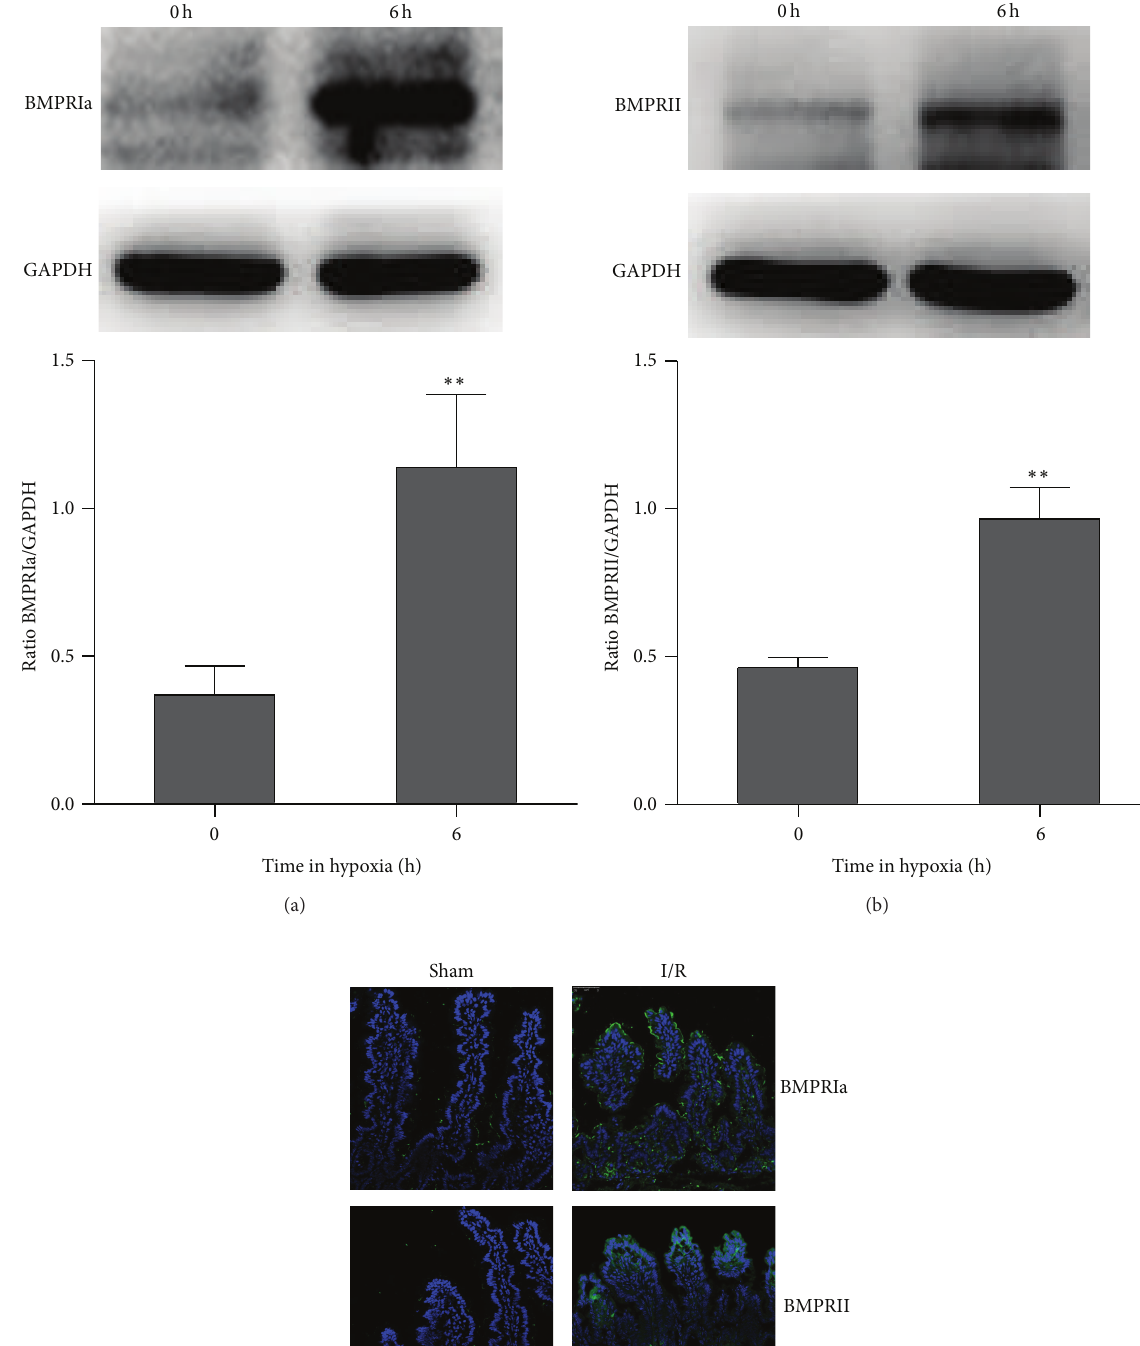
Figure 2: (a) and (b), (c) BMPRIa and BMPRII expression was detected by Western blotting and immunofluorescence staining. BMPRIa and BMPRII expression levels were both significantly increased after 6 h of hypoxia in IEC-6 cells. ∗∗ 𝑃 < 0.01 versus control. BMPRIa and BMPRII expression in the intestinal mucosa also increased after I/R for 1h compared to the control. Data are representative of 3 similar